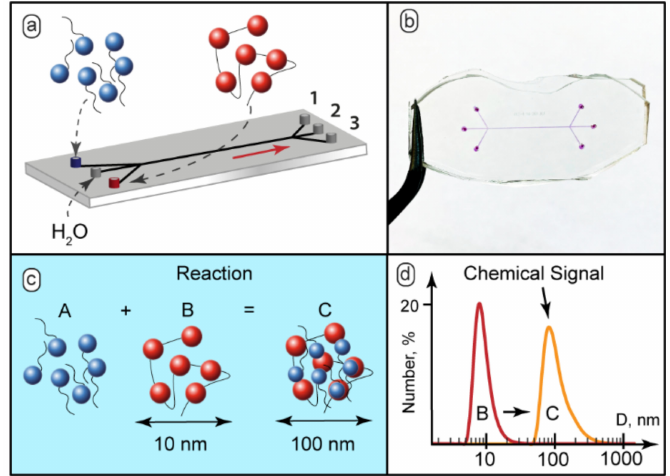
Figure 1. ( a ) Schematic diagram of feeding the reacting solutions and the solvent into a microfluidic chip and separating the reaction mixture into 3 streams; ( b ) The 3-input and 3-output microfluidic chips with width = 200 µ m and length = 15 mm, the microchannels were filled with dye (phenolph- thalein in 0.1 M KOH) to aid visualization; ( c ) SDS binding by PDADMAC macroions; ( d ) Chem- ical signal detection by DLS: initial 10–15 nm polymers macromolecules or smaller particles and 100–150 nm aggregates of complexes. The SDS:PDADMAC molar ratio in the test reaction was 0.2:1. For further microfluidic experiments, therefore, we used 6.1 × 10 − 3 mol/L